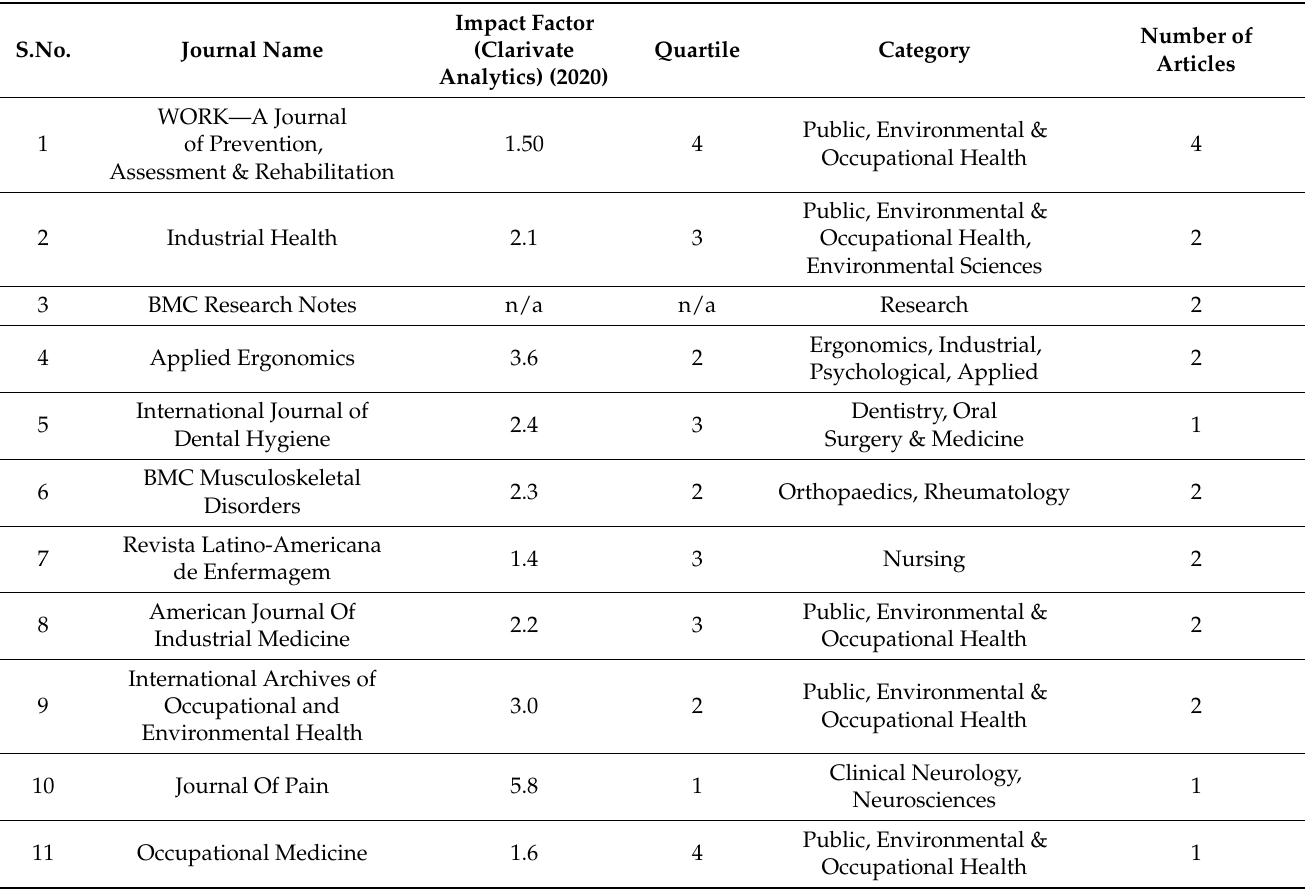
Table 3. Top Journals with their contribution to the 50 most-cited articles on WMSDs using NMQ related to healthcare